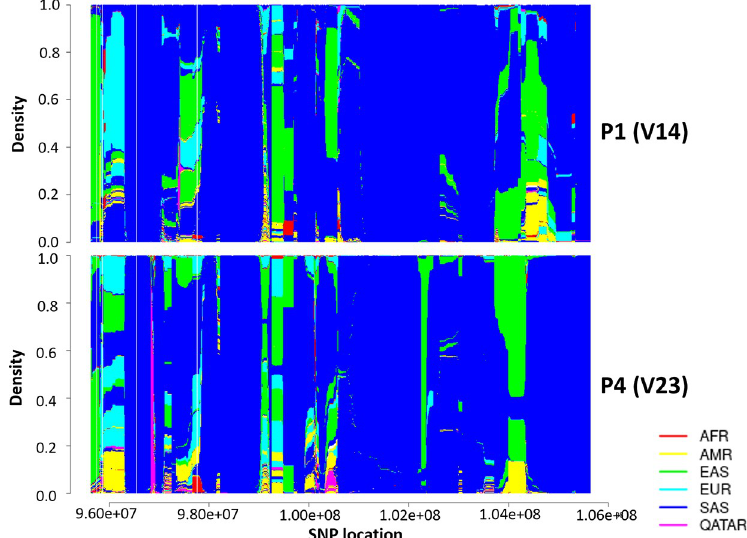
Fig 4. Haplotype ancestry prediction with the global population using fineSTRUCTURE. South Asian ancestry predicted the haplotype for locus 5MB upstream and 5MB downstream to loci chrX:100,624,323–100,629,619 (hg19/ GRCh37) of two affected patients (V14 and V23) with 2504 individuals of five major populations (AFR-African, AMR- American, EAS- East Asian, EUR-European, and SAS-South Asian) of 1000 Genome Project and 44 individuals of Qatari